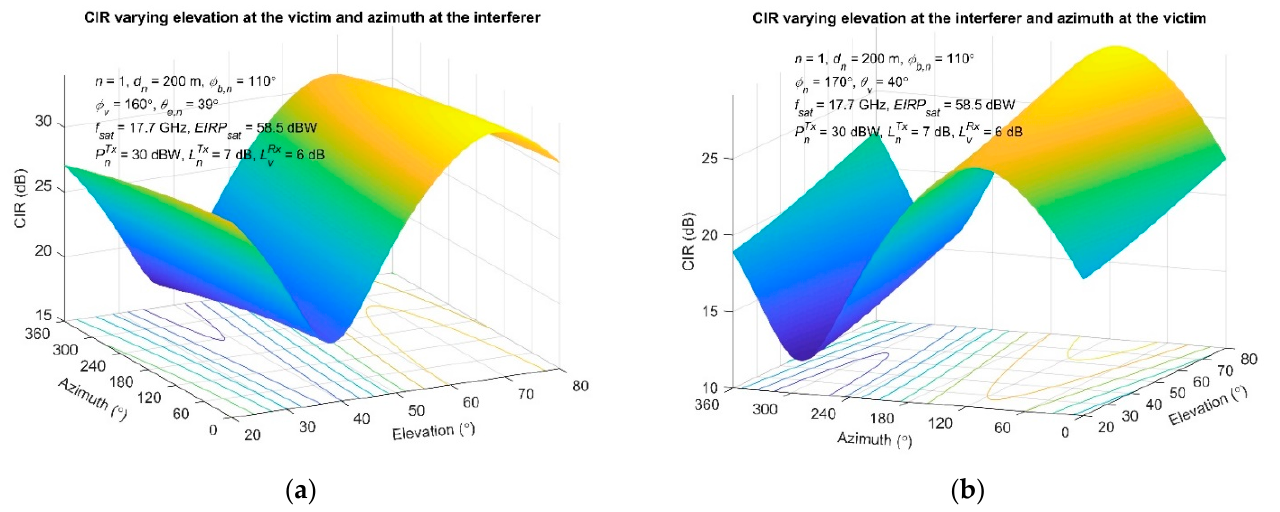
Figure 6. Achieved CIR at the victim side varying the parameters: ( a ) elevation at the victim and azimuth at the interfering station; ( b ) elevation at the interfering station and azimuth at the victim station.